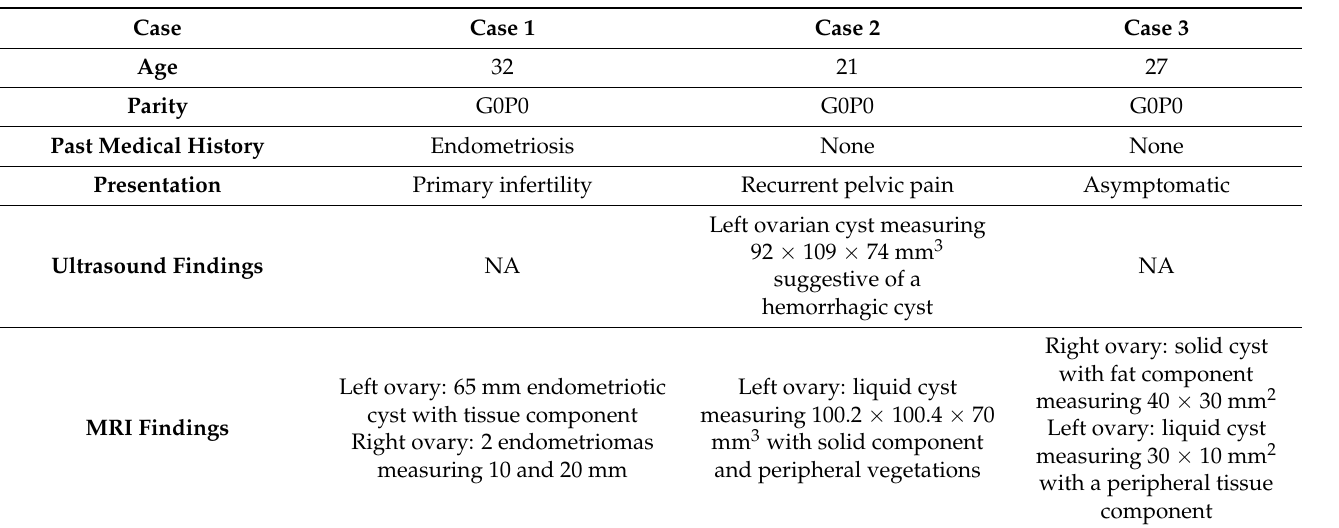
Table 1. Characteristics and outcomes of three young women with serous